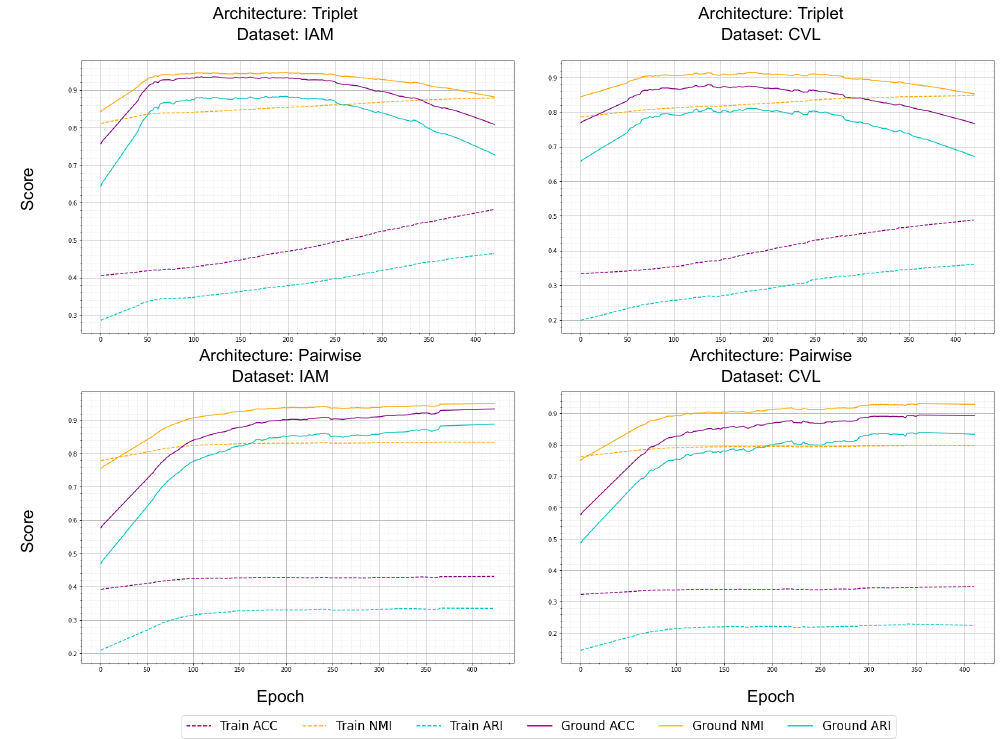
Figure 8. Graphs illustrating the metrics of the pretext task and ground dataset containing 50 writers with a purity of 0.05. The first row represents the triplet network and the second row represents the pairwise network,